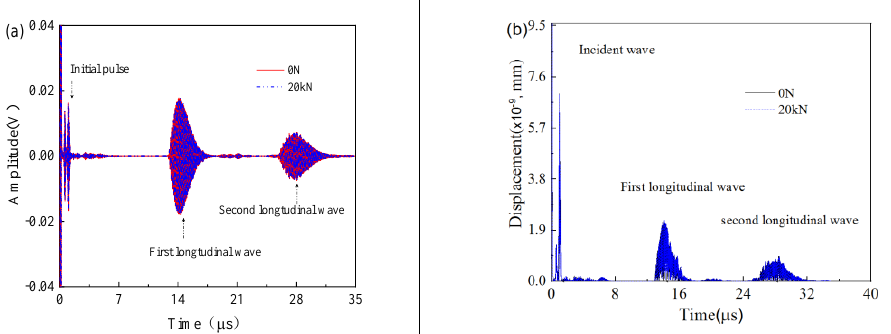
Figure 4. ( a ) The simulated temporal ultrasonic signal inside the nickel − based superalloy bolt, ( b ) displacement field contrast of the upper surface between the bolt with 20 kN axial preload applied and the slack bolt.